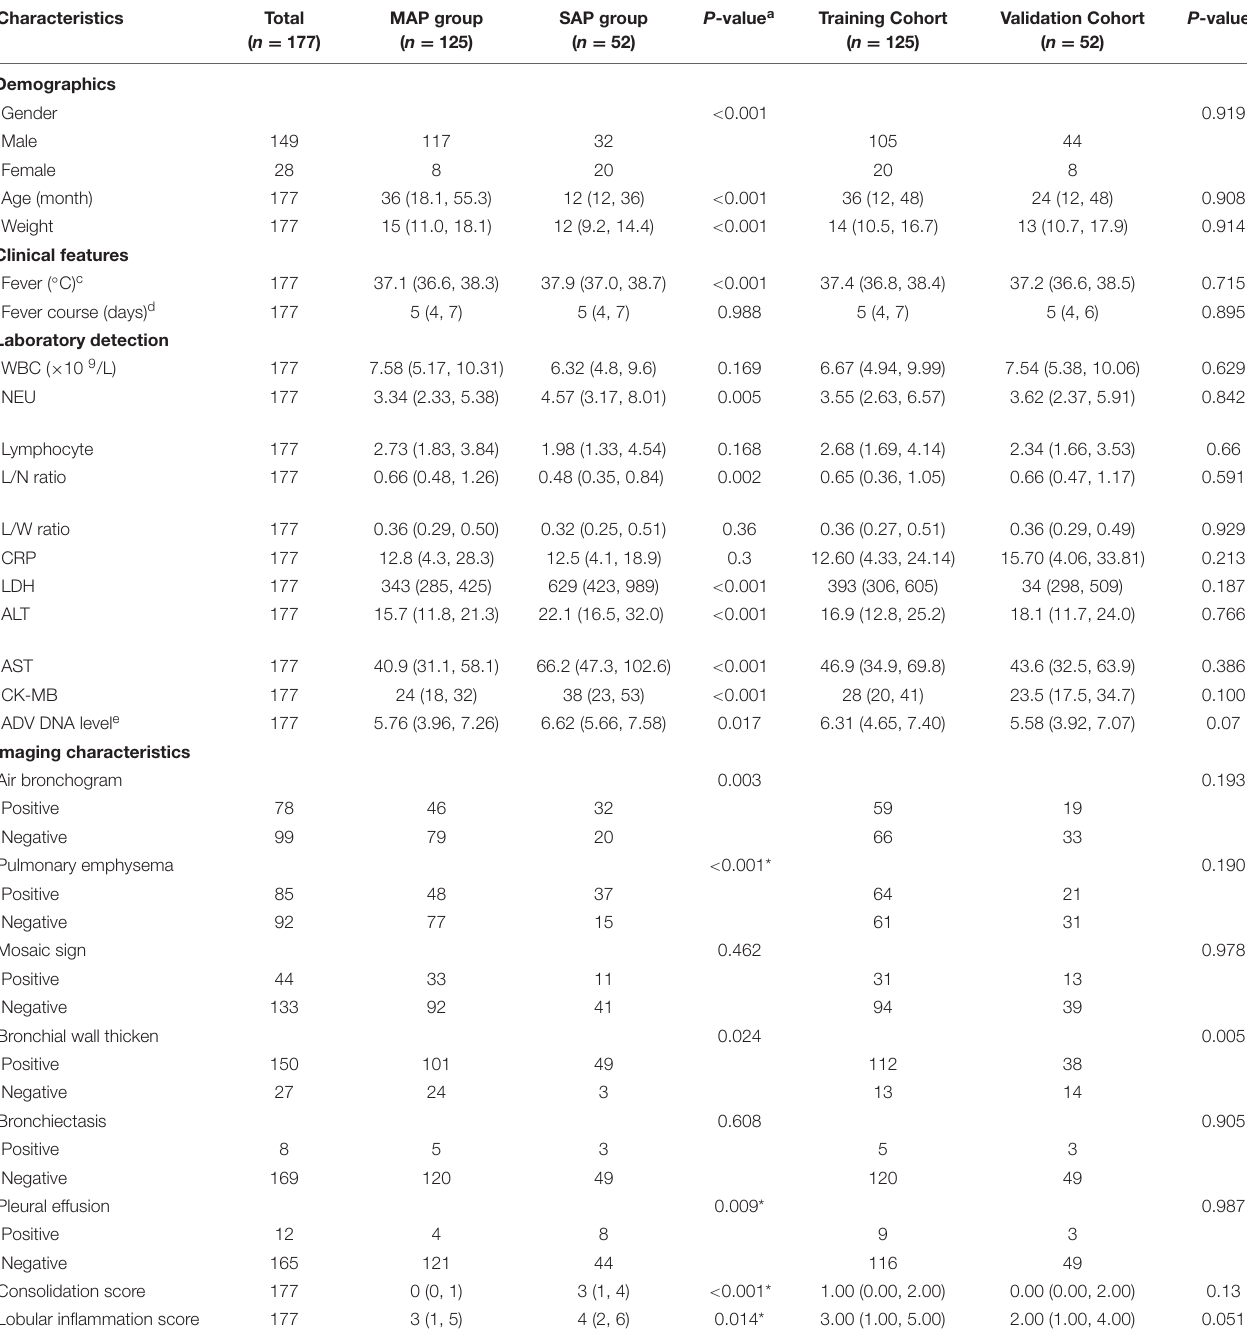
TABLE 1 | Demographic, clinical and chest CT findings of patients with adenovirus pneumonia included in the study.